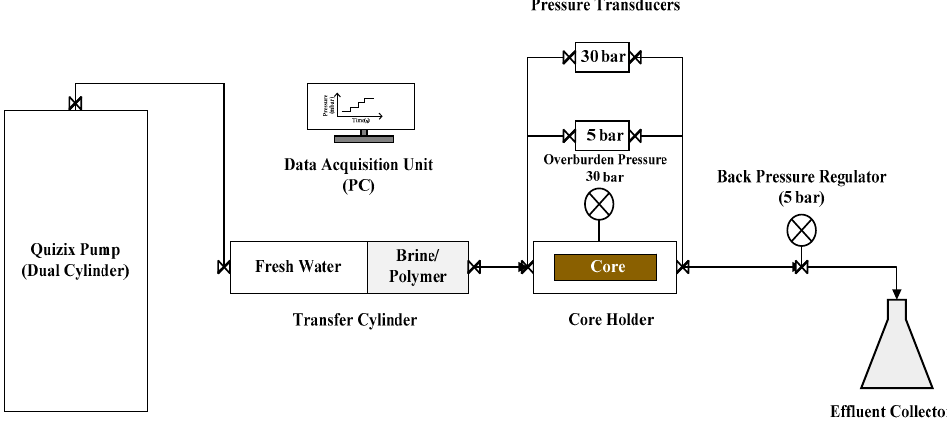
Figure 2. Schematic diagram of the core flooding apparatus.